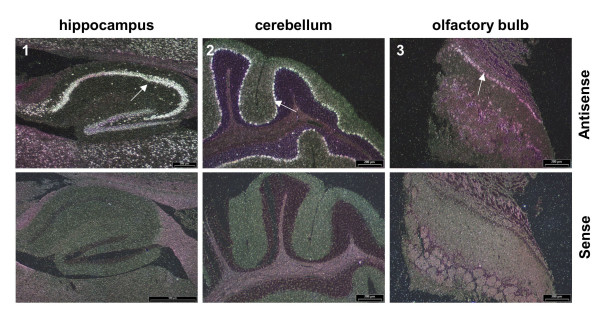
Expression of Atp6ap1 in brain. All sections are sagittal and from adult NMRI mice. Upper panel: antisense probe, lower panel: sense probe. 1 hippocampal formation with signal in CA1-CA3 pyramidal cells, 2 cerebellum with signal in purkinje cell layer, 3 olfactory bulb with signal in mitral cells.